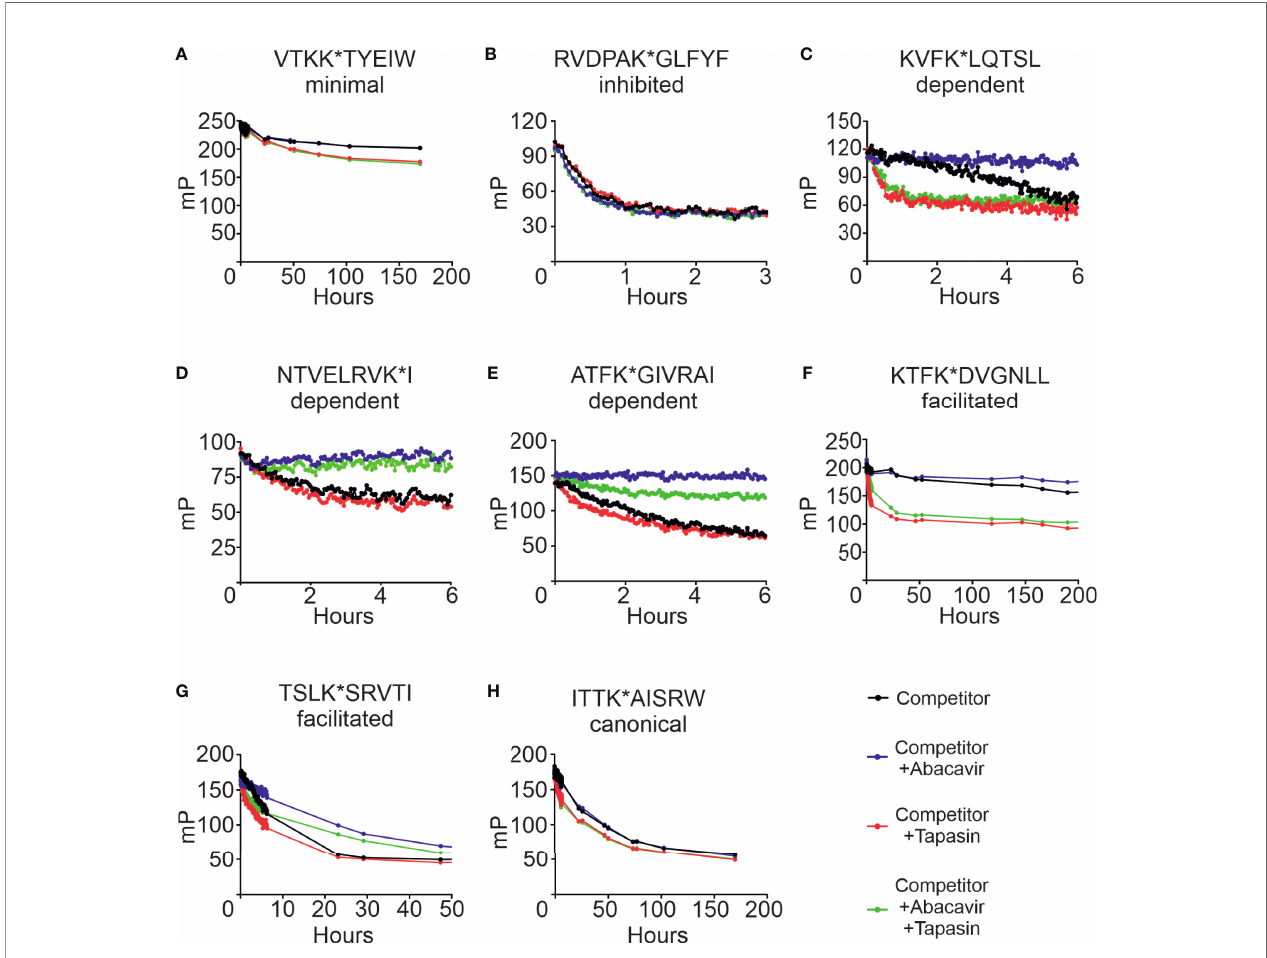
FIGURE 7 | Abacavir diversi fi es the HLA-B*57:01 peptide repertoire by decreasing dissociation of speci fi c peptides. Conditional ligand loaded HLA-B*57:01fos molecules were UV exposed and incubated with the indicated fl uorescent peptide ( A = VTKK*TYEIW, B = RVDPAK*GLFYF, C = KVFK*LQTSL, D = NTVELRVK*I, E = ATFK*GIVRAI, F = KTFK*DVGNLL, G = TSLK*SRVTI, H = ITTK*AISRW). Fluorescence polarisation measurements were taken after the addition of excess unlabelled competing peptide in the absence or presence of abacavir and/or conjugated tapasin-jun-ERp57 C60A proteins. Data shown are representative of triplicate or greater